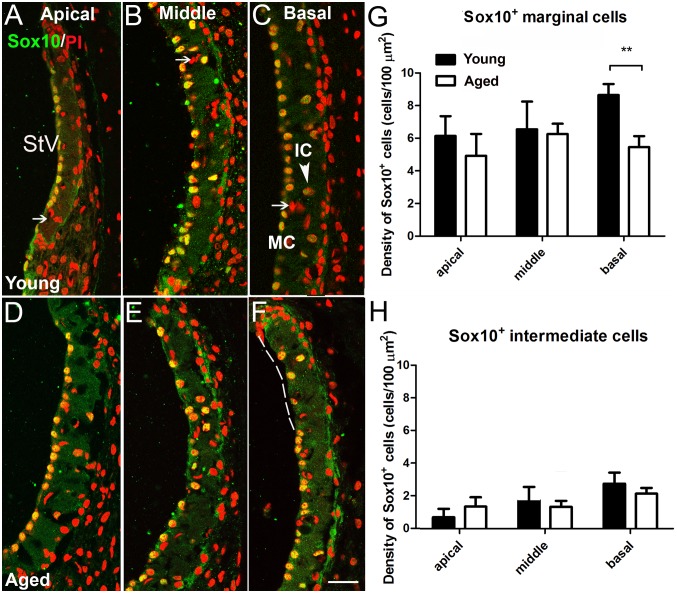
Age-related reduction of Sox10+ cells in the stria vascularis.Sox10+ marginal cells (MCs) and intermediate cells (ICs, arrowhead) were seen in the StV of young adult (A–C) and aged (D–F) mice. Endothelial cells and other cell types associated with strial microvascular structures were unstained with the Sox10 antibody (arrows). The dashed line in F indicates a region showing a complete loss of Sox10+ cells at the upper surface of the StV in the basal turn of an aged mouse. (G) Numbers of Sox10+ MCs decreased significantly in the basal turn of aged CBA/CaJ mice (n = 6, **p<0.01). Sox 10+ cells were also reduced in the apical turn, however, this difference was not significant. (H) Sox10+ ICs decreased in the middle and basal turns of aged ears, however, this reduction was not significant (n = 6, p>0.05). Scale bar: 20 µm in F (applies to A–F).